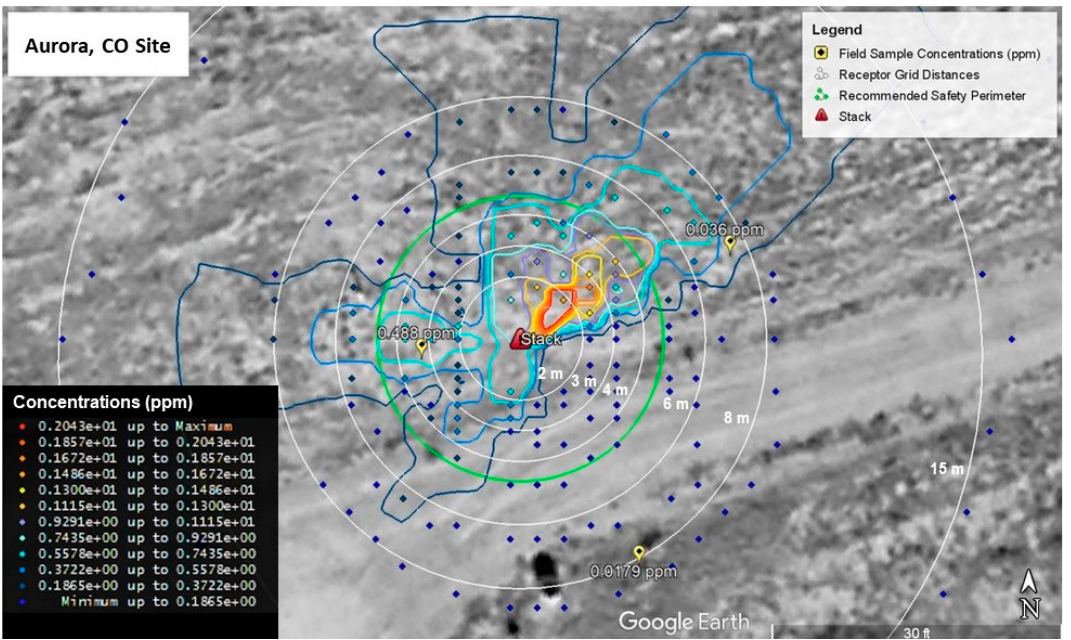
Figure 6. Modelled Styrene Emission Calibrated to Field Sample Concentrations (Aurora, CO, USA).